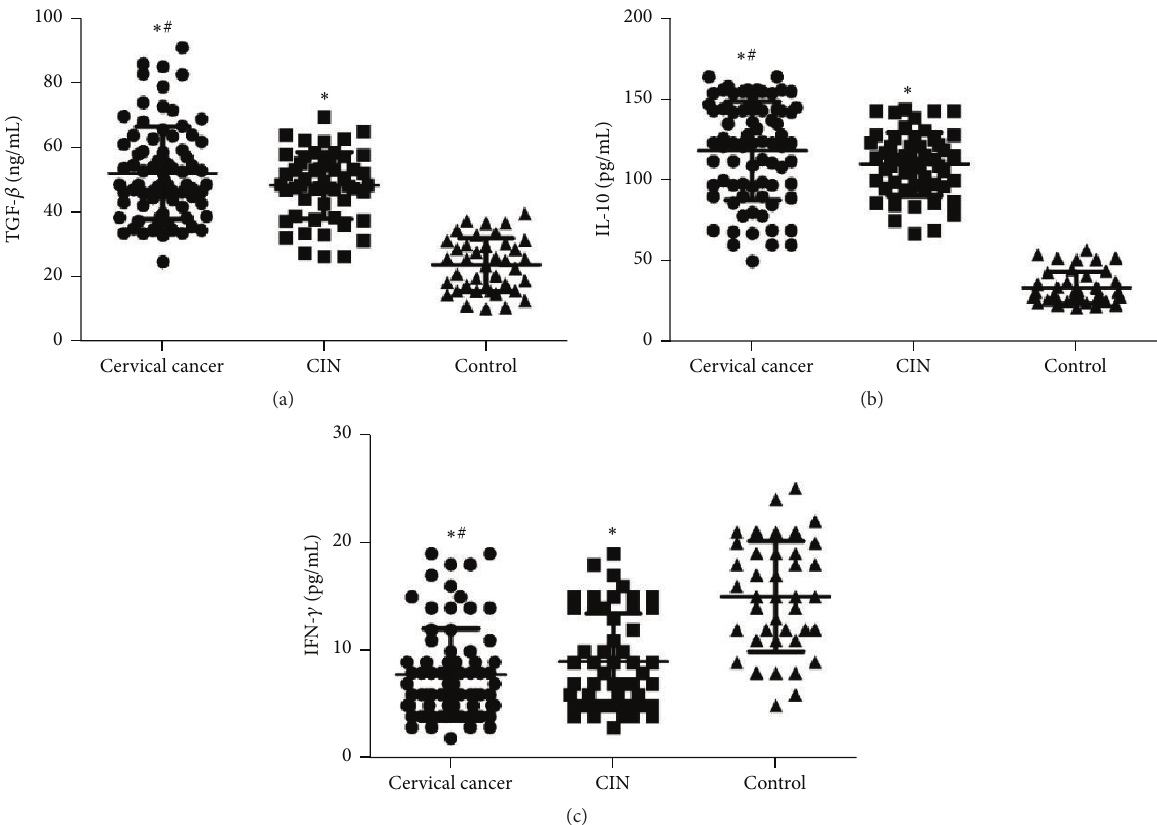
Figure 2: Contents of cytokines related with PD-1 and PD-L1. ELISA was performed to measure the levels of TGF- 𝛽 , IL-10, and IFN- 𝛾 in normal control, CIN, and cervical cancer groups. ∗ 𝑃 < 0.05 compared with control group; # 𝑃 < 0.05 compared with CIN